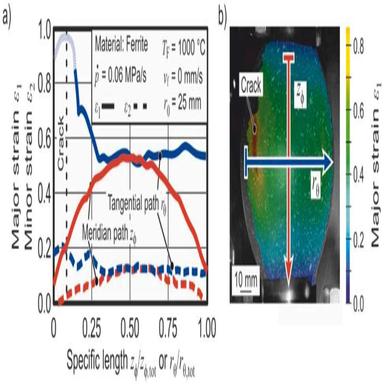
a) Principal strain distribution after a crack occurred over the tangential rθ – such as meridian zϕ paths and b) used DIC image as well as the corresponding paths for the evaluation (Values over the crack are interpolated – indicated as light blue/dashed in the diagram).